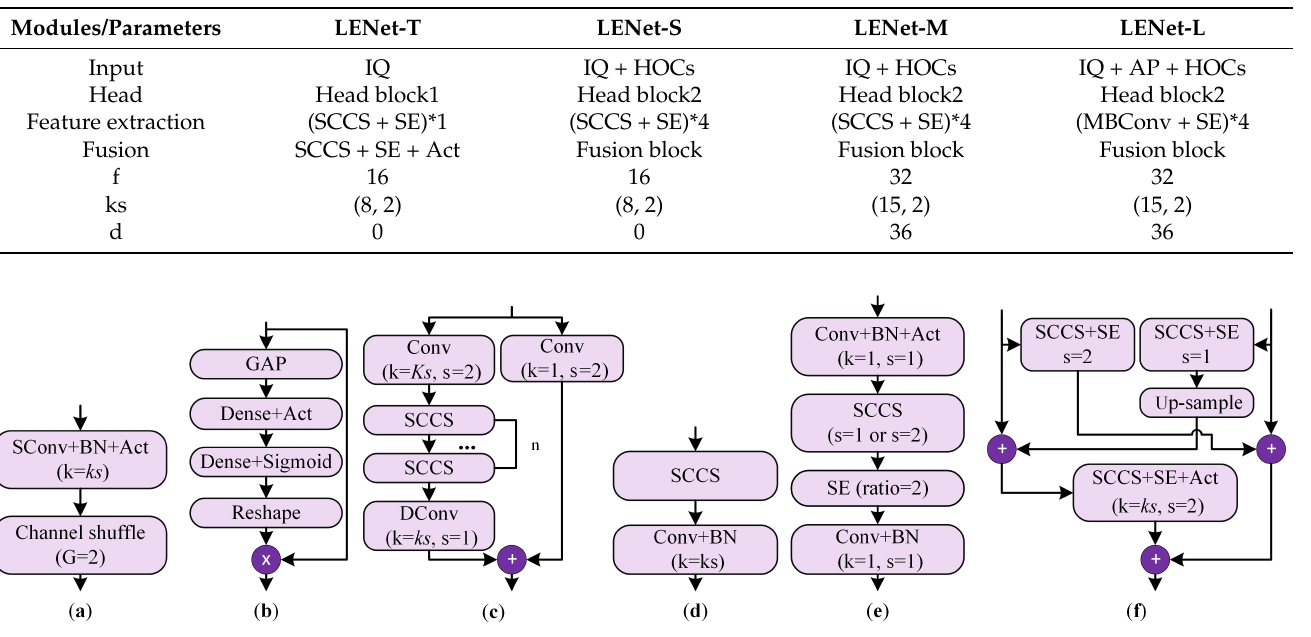
Table 1. Configuration information for LENet models.